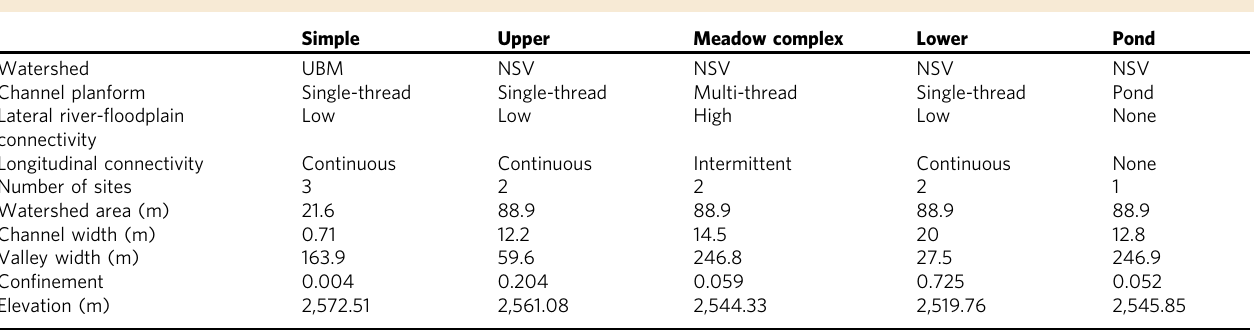
Table 1 Physical characteristics of sampling sites